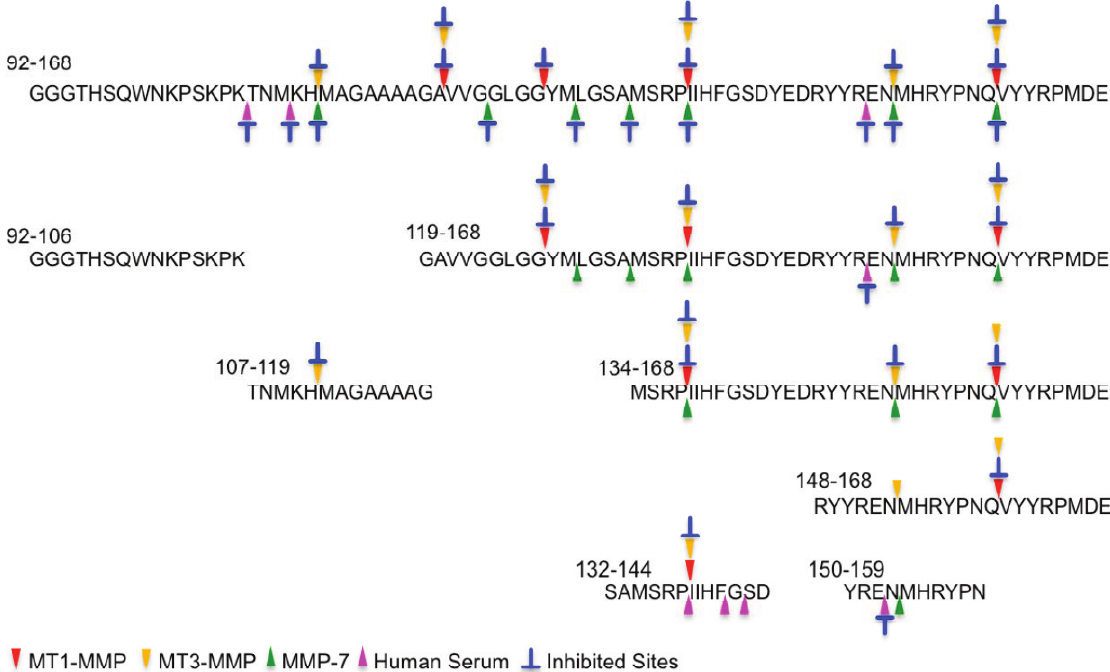
Figure 4. Cleavage sites on the central region peptides. The cleavage sites are marked with colored triangles: MT1-MMP, red arrow; MT3-MMP, yellow arrow; MMP-7, green arrow; HS, pink arrow and the inhibited sites (blue) are indicated.